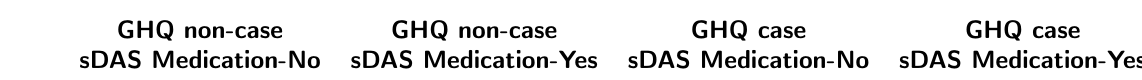
Table 1: Characteristics of population subgroups classified according to GHQ-12 caseness and sDAS medication